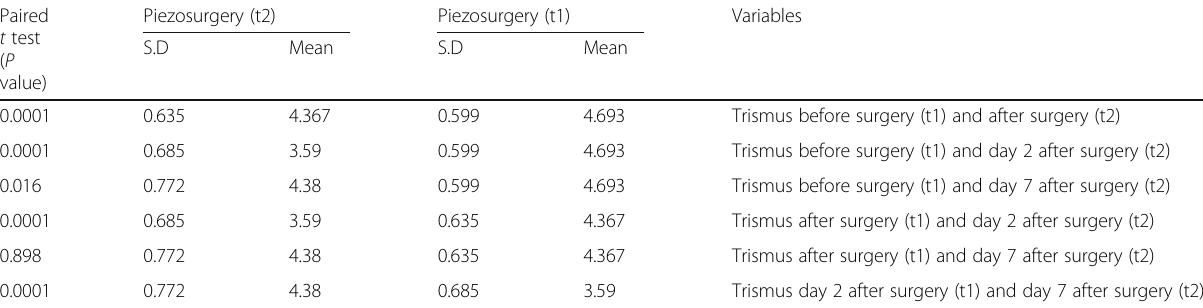
Table 6 Comparison of trismus variable at different times of piezoelectric surgery Paired t test ( P